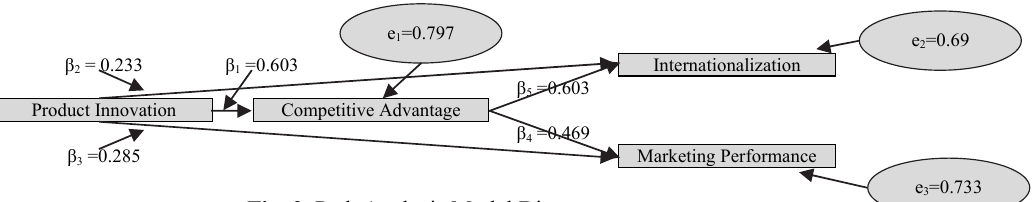
Fig. 3. Path Analysis Model